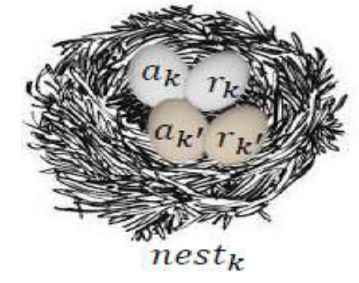
Figure 5. Quality Analysis of Host Bird’ Egg and Cuckoo Bird’ Egg